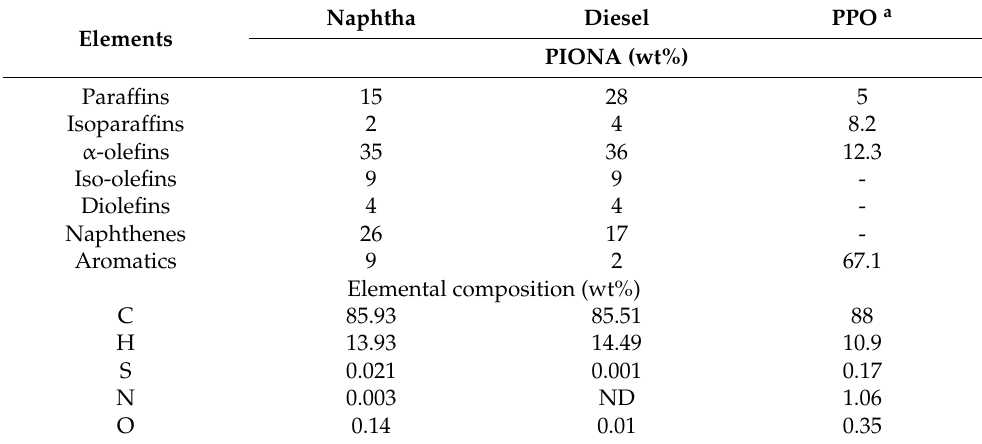
Table 8. PIONA and elemental composition of naphtha, diesel and PPO determined by comprehen- sive two-dimensional gas chromatography analysis [77] .